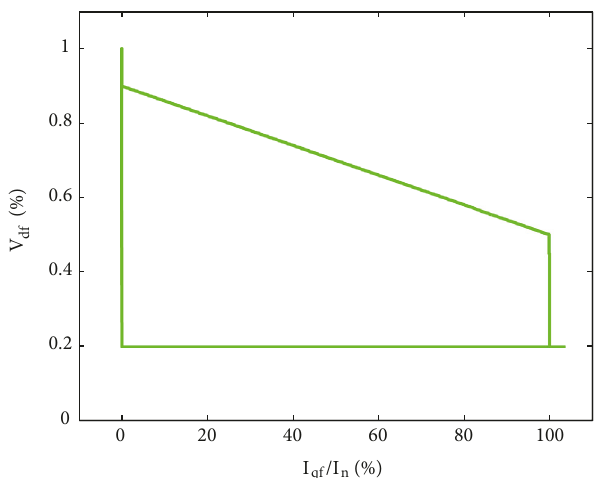
Figure 12: The percent of injected reactive current to the grid versus the voltage drop of